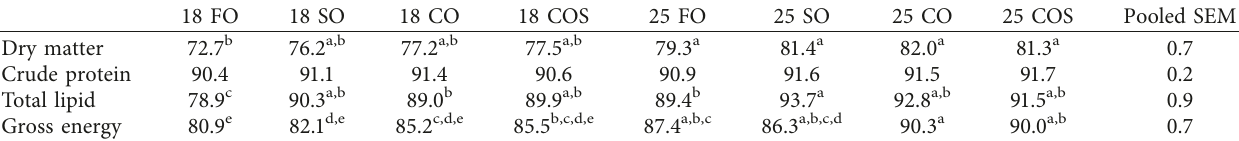
Table 7: Apparent digestibility coefficients (ADC) of experimental diets (g/100g TL). 18